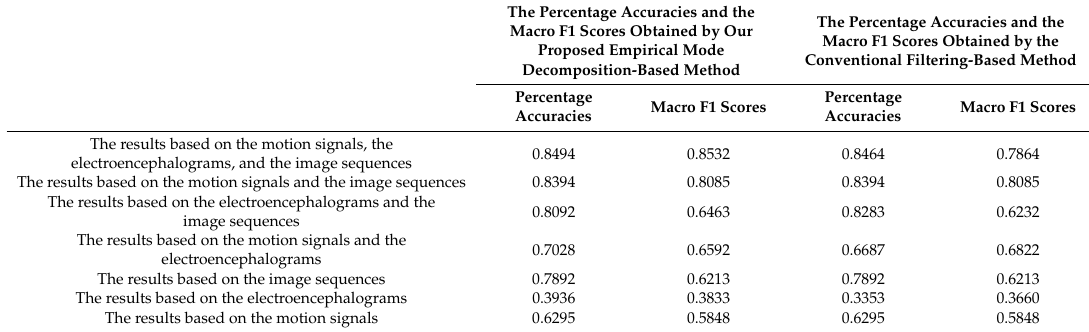
Table 6. The percentage accuracies obtained by our proposed empirical mode decomposition-based method and the conventional filtering-based method using the signals acquired from the fifth volunteer.